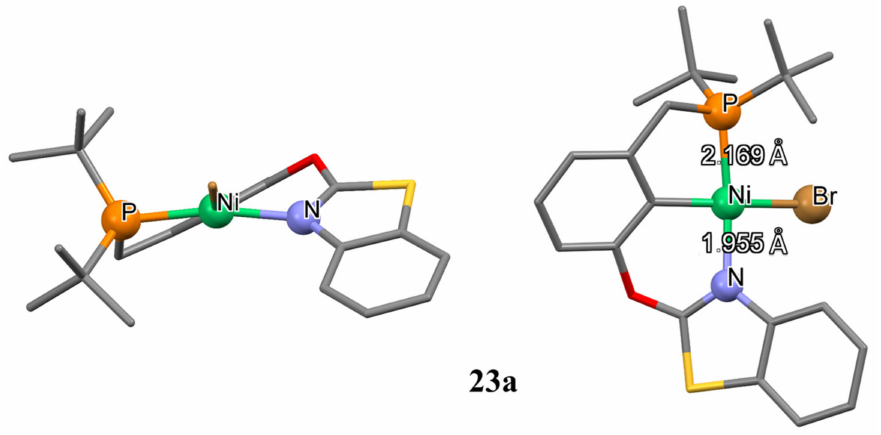
Figure 5. Crystal structure of the benzothiazole-based PCN pincer nickel bromide 23a [107]. Table 2 represents the comparison of P-Ni and N-Ni bond distances of analogous PCN nickel pincers with different N-donor groups (dimethylamine for 14a , pyrazole for 21c and benzothiazole for 23a ). The corresponding distances of 21c and 23a are almost equal due to the similar basicity of N atom in the thiazole and pyrazole rings ( pK a of the conjugate acid 2.50 vs. 2.48 for thiazole and pyrazole, respectively), while a higher pK a value of the dimethylamine (10.73) indicates stronger basicity. Since lower pK a values of electron-poor pyrazole and benzothiazole groups indicate their weaker σ -donor ability, these groups more likely dissociate from the metal center, yielding more pronounced hemilability, which